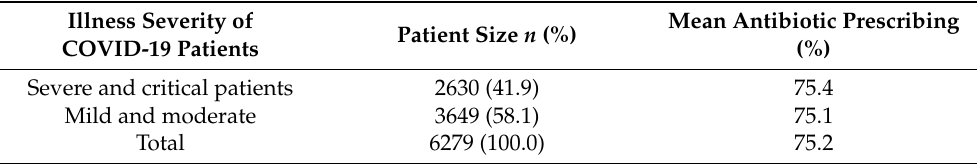
Table 1. Severity of illness and antibiotic prescribing.